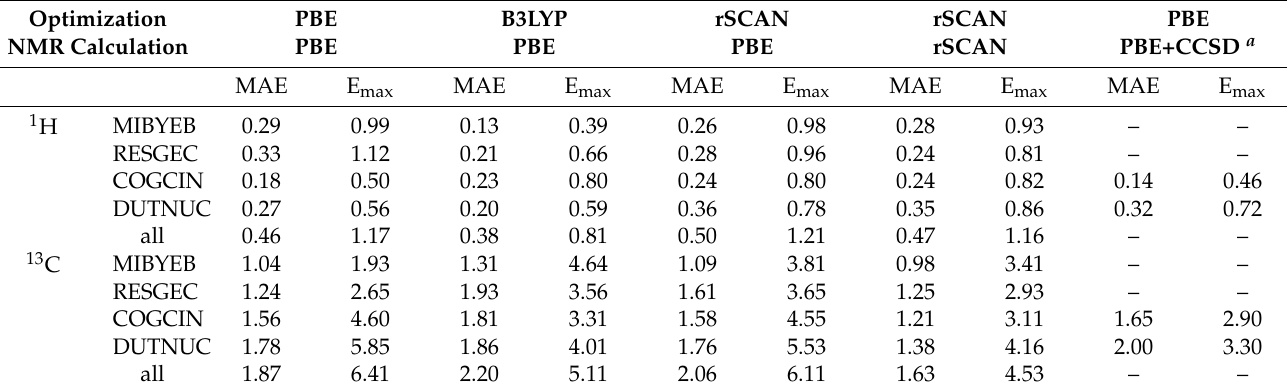
a Periodic calculation at the PBE level with isolated-molecule corrections at the CCSD level. The proton-shielding calculations (at the PBE level) performed on the geometries optimized at the B3LYP level are in substantially better agreement with the experiment than the calculations on the PBE-optimized geometries, with both the MAE and E max values having dropped significantly. The largest maximum error (0.80 ppm) has been observed for the COGCIN system (Table